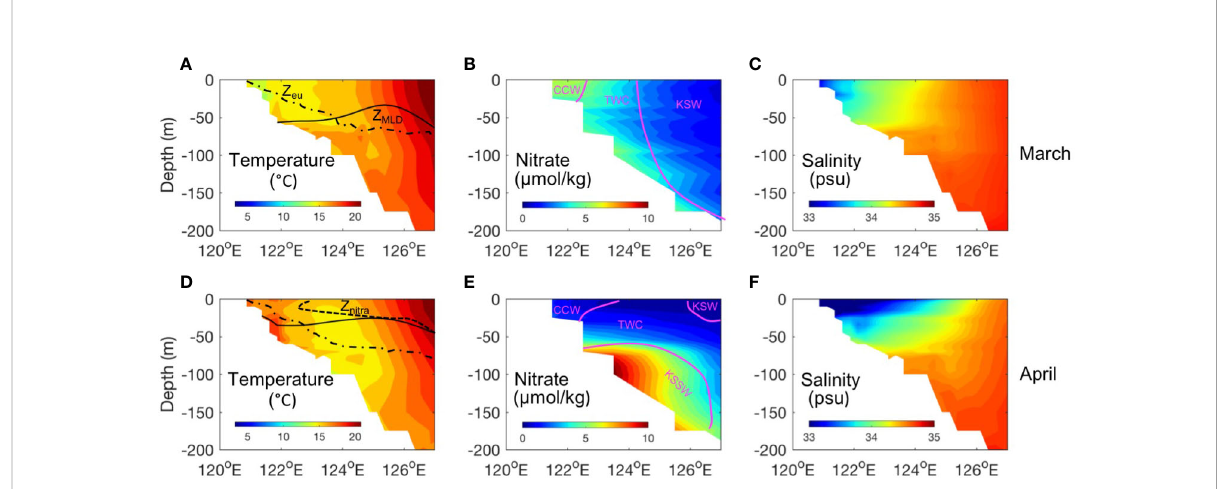
FIGURE 11 WOA18 climatology distributions of temperature (A, D) , nitrate (B, E) , and salinity (C, F) at the 28°N section. The black line denotes the mixed layer depth. The black dashed line denotes the nitracline depth (nitrate concentration exceeds 0.5